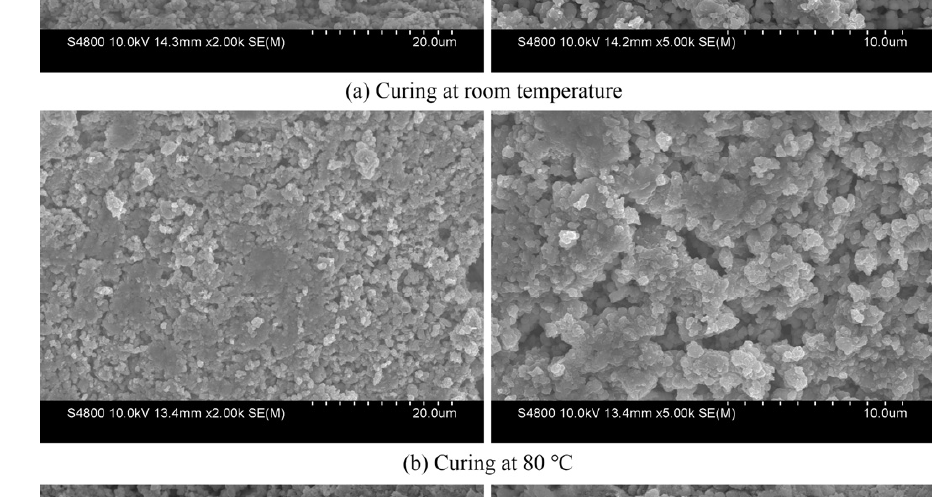
Figure 5. Curing at room temperature (Figure 5a), the geopolymer is made up of porous, loose gel particles. As the curing temperature increases (curing at 80 ◦ C) (Figure 5b), the porosity between the cementing products decreases and the density improves. Curing in the autoclave (Figure 5c), the geopolymer shows continuous and denser gels, indicating that the degree of polymerization of the geopolymer is further improved. A small part of the unreacted raw materials and the zeolite crystal structure is embedded in the geopolymer gel phase to form a uniform and dense structure, bringing about a high strength and stiffness of the geopolymer. The same conclusion can be obtained in the microstructure of the RM-FA geopolymer in Figure 6.